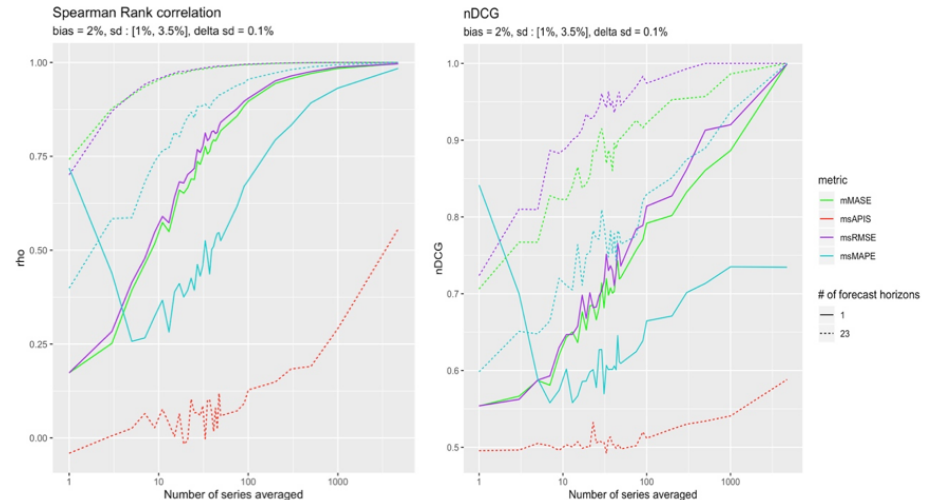
Figure 9. Spearman Rank correlation and nDCG for ( + + + ) configuration.